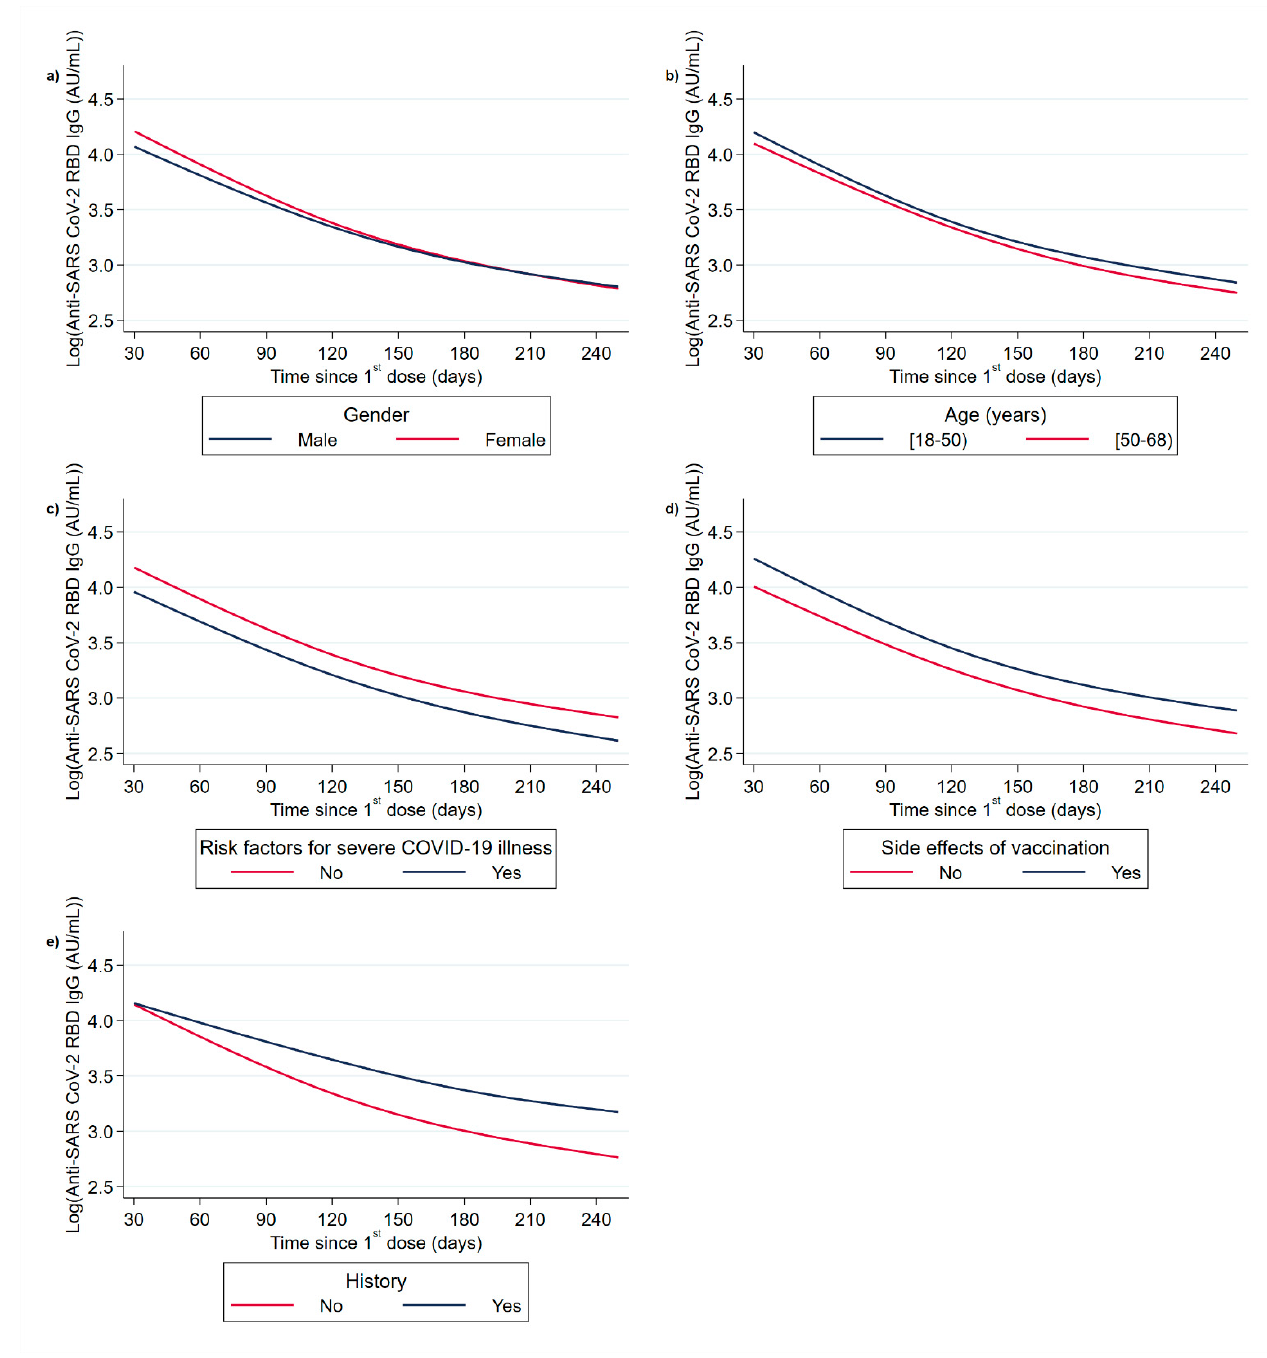
Figure 2. Waning, based on mixed model, of anti-SARS - CoV - 2 RBD IgG antibody levels over time from the first dose by ( a ) gender, ( b ) age, ( c ) risk factors for severe COVID-19 illness, ( d ) side effects of vaccination, and ( e ) history of COVID - 19 infection in pre-vaccination period.